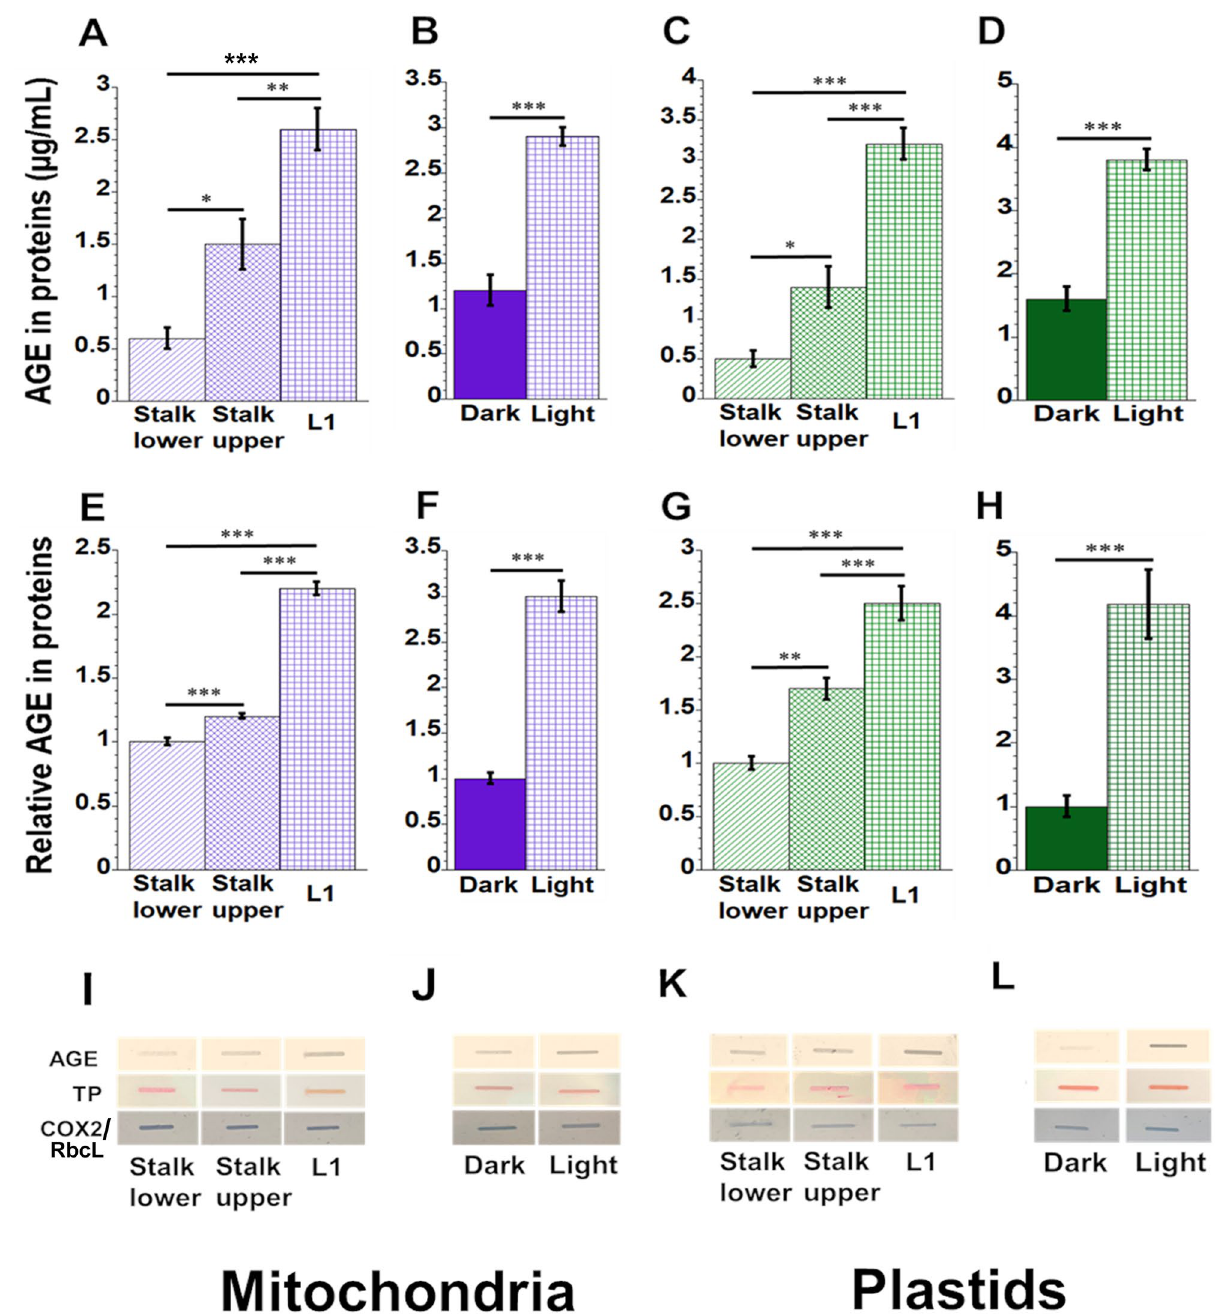
Figure 2. AGE in maize mitochondria and plastids. The amount of AGE in proteins extracted from isolated mitochondria and plastids was measured using anti-AGE antibodies with a competitive ELISA ( A – D ) and slot blot ( E – L ) assays. For the ELISA assay the levels of AGE in total mitochondrial and plastid proteins were measured as µg/mL. Representative images of slot blot assays are shown in ( I–L ) and the relative AGE in protein was determined, where the image intensity was set to 1 for stalk lower in ( E , G ) and for dark-grown leaves in ( F , H ). Uppermost panels of ( I – L ) show AGE proteins, middle panels show the total protein (TP) levels in samples, and lowermost panels show mitochondrial (COX2)- and plastid (RbcL)-specific proteins (COX2 in panels I and J; RbcL in panels K and L). Equal amounts of protein extracted from the different tissues were used in these assays. Data here and in Figs. 3, 4, 5, 6 are represented as mean ± SEM. Statistically significant differences were measured using ANOVA statistic test with post hoc analysis using Tukey’s HSD and are shown as asterisks, where * P -value ≤ 0.05, ** P -value ≤ 0.01, *** P -value ≤ 0.001 are indicated on respective